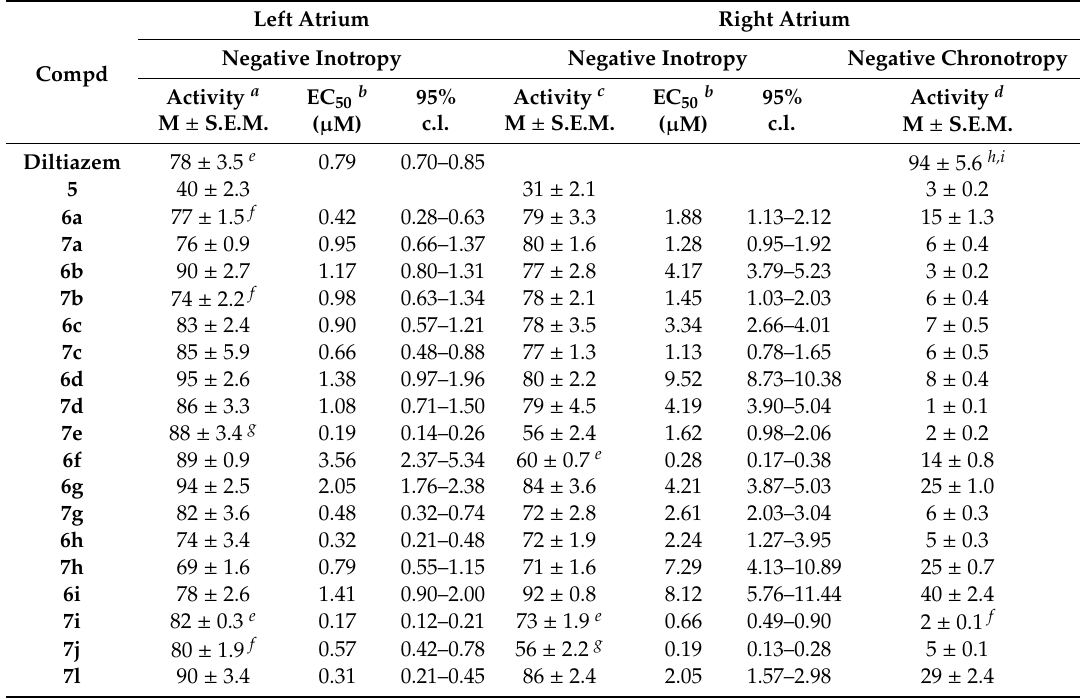
Table 1. Cardiac Activity of Tested